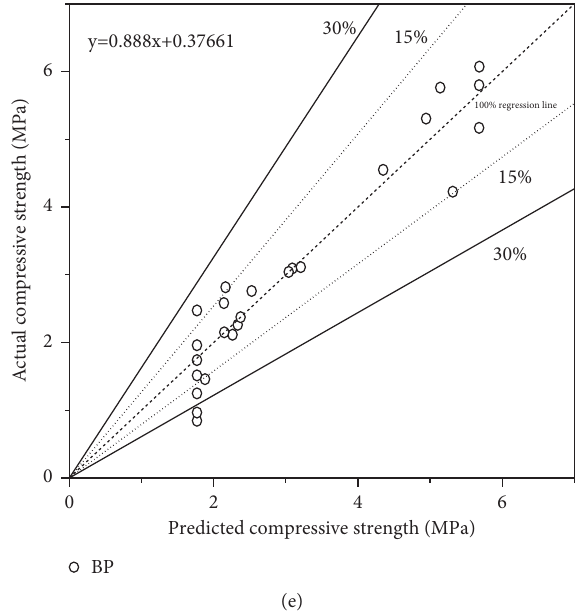
Figure 12: Scattered distribution diagram of predicted and actual values of each model.